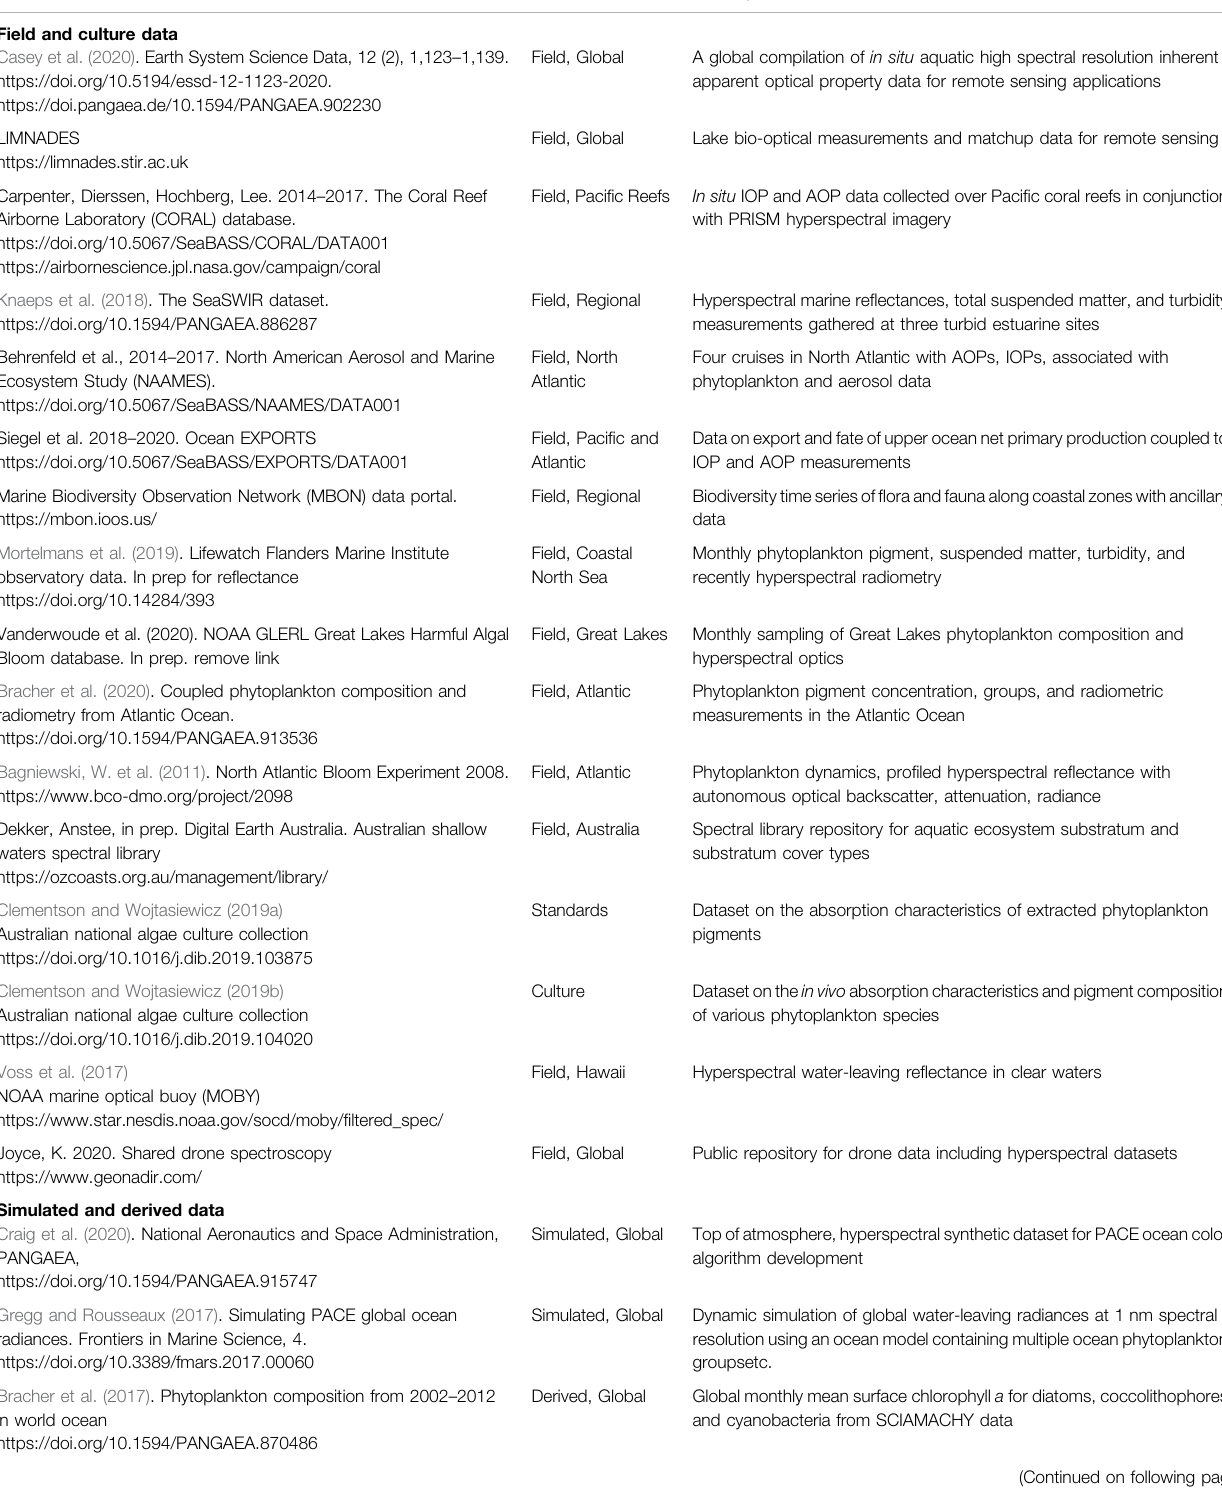
TABLE 4 | Hyperspectral aquatic optical and biodiversity